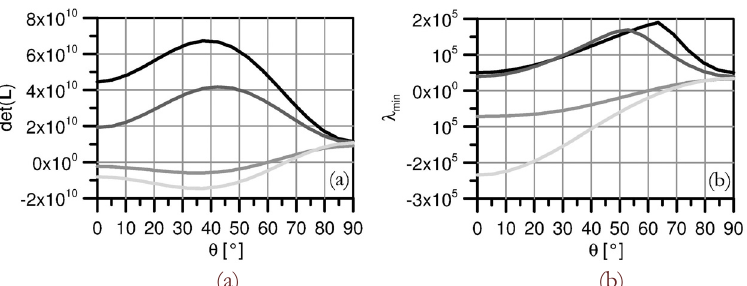
Figure 10: Example 1: determinant of localization matrix (a) and minimum eigenvalue (b) for different configurations of n vector. Colours of line refer to the stages indicated in Fig.